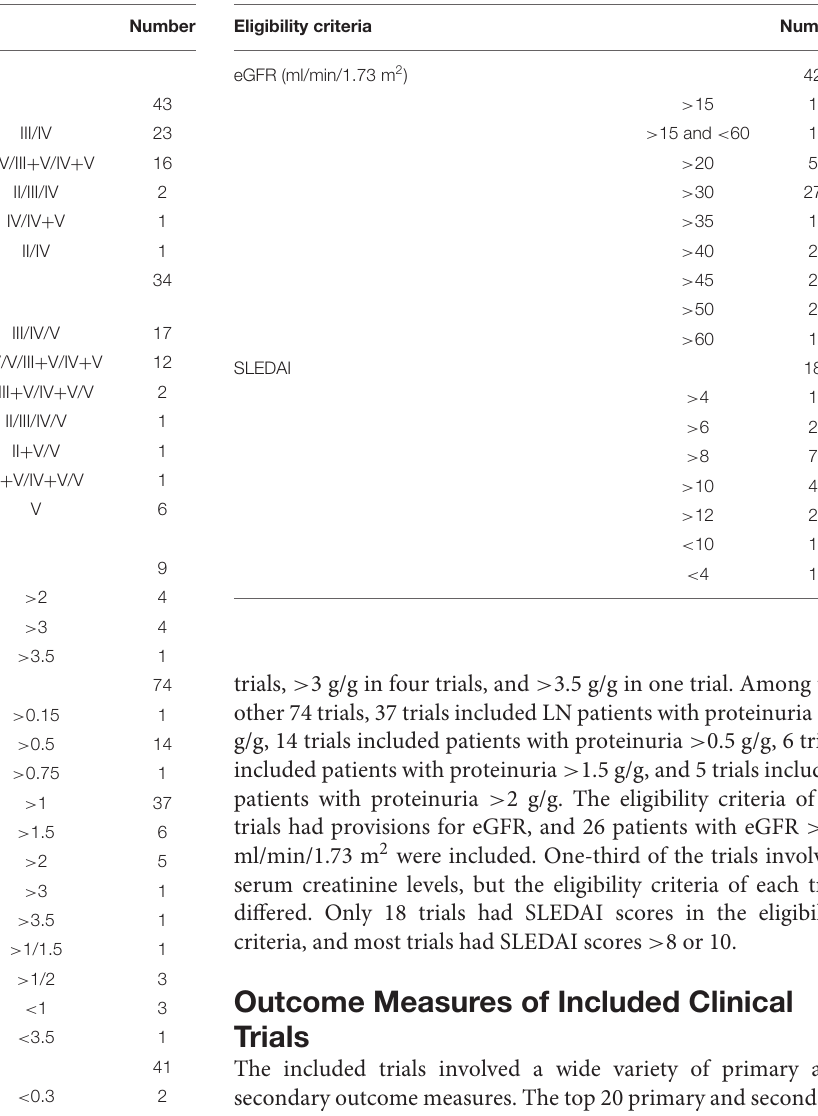
TABLE 2 | Eligibility criteria of included clinical